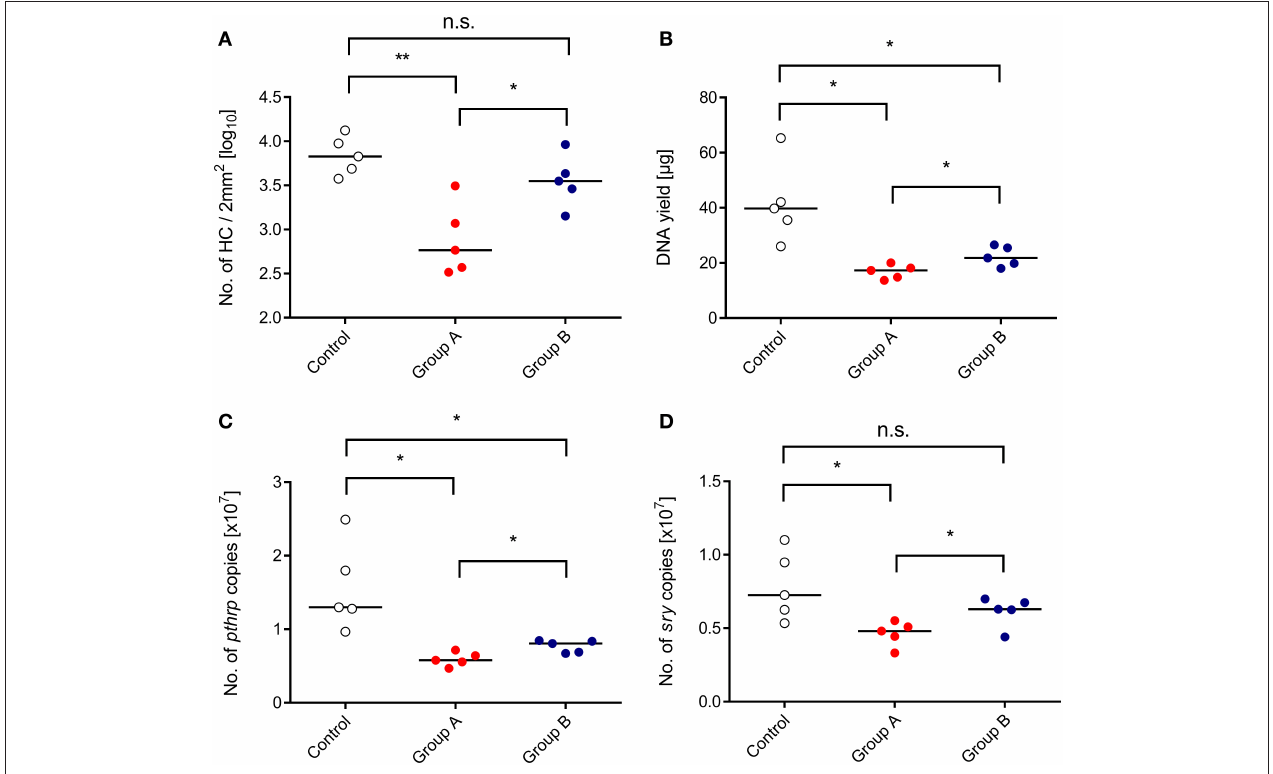
FIGURE 4 | Inhibition of BM repopulation by CMV and its restoration by CTL transfer. (Control) HCT only. (Group A) HCT and infection. (Group B) HCT, infection, and immunotherapy with CTL. The indicated parameters of BM repopulation refer to day 14 throughout. (A) Hematopoietic cell (HC) counts refer to representative 2-mm 2 section areas of sternal and vertebral BM. All other parameters (B–D) refer to BM cell yields pooled from both femora and both tibiae of individual mice. Symbols represent mice analyzed individually. Median values are marked. Differences between two experimental groups were determined by Student’s t -test based on log-transformed data (upper left panel) or on non-transformed data (remaining panels). Significance levels: P -values of < 0.05 (*), and < 0.01 (**). n.s., not